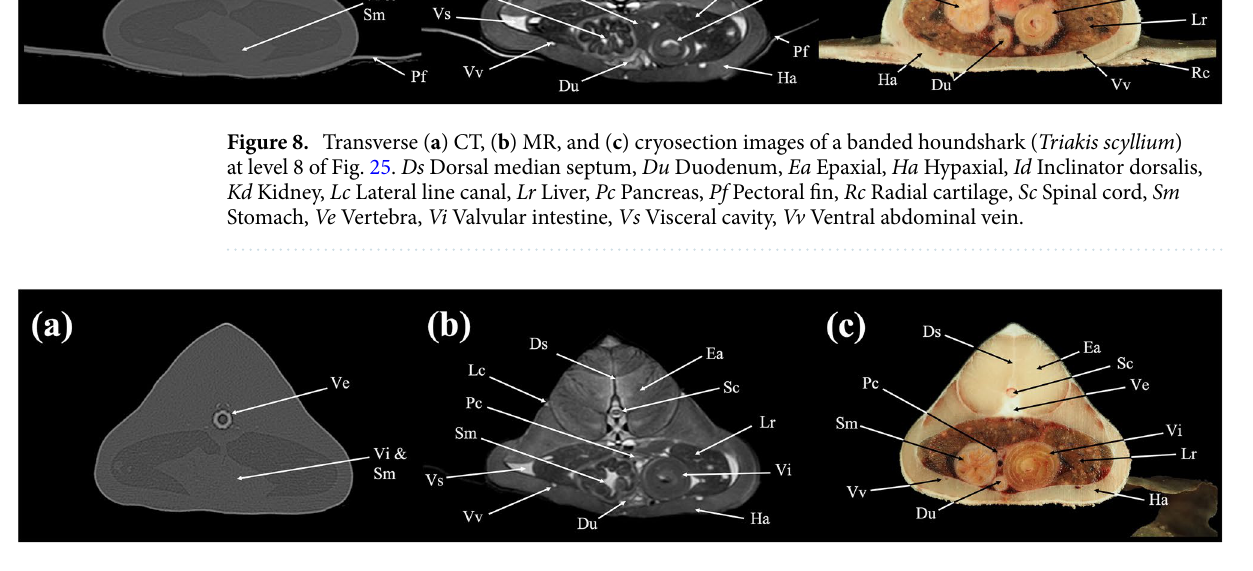
Figure 9. Transverse ( a ) CT, ( b ) MR, and ( c ) cryosection images of a banded houndshark ( Triakis scyllium ) at level 9 of Fig. 25. Ds Dorsal median septum, Du Duodenum, Ea Epaxial, Ha Hypaxial, Id Inclinator dorsalis, Kd Kidney, Lc Lateral line canal, Lr Liver, Pc Pancreas, Rc Radial cartilage, Sc Spinal cord, Sm Stomach, Ve Vertebra, Vi Valvular intestine, Vs Visceral cavity, Vv Ventral abdominal vein.